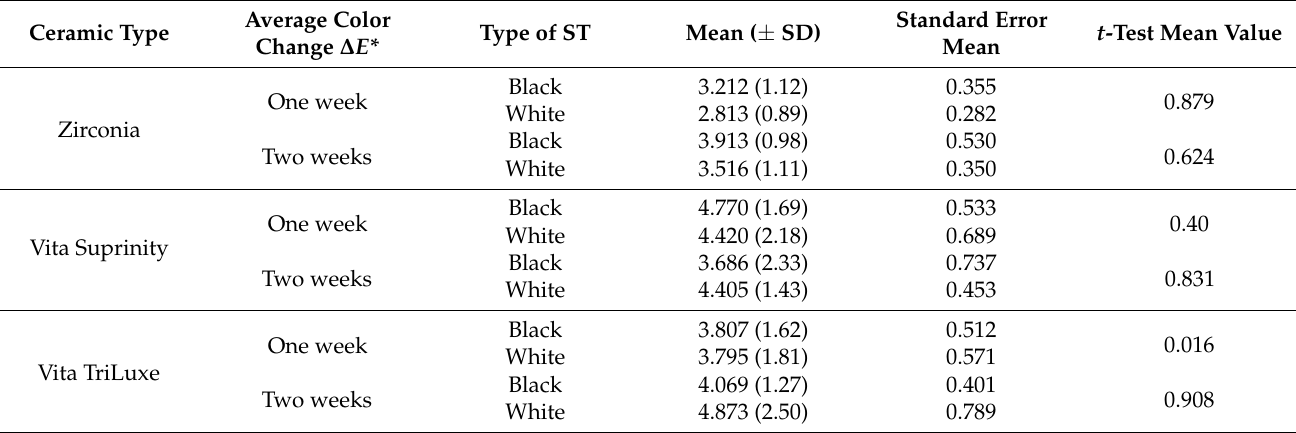
Table 2. Student t -test for ∆ E* of different ceramic materials, concerning first- and second-week interval and ST type.